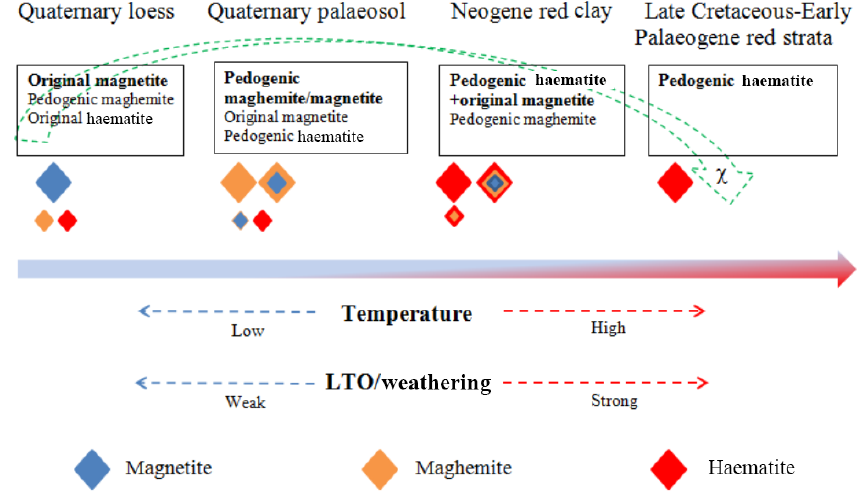
Figure 9. Cartoon illustrating the dominant magnetic minerals and χ changes from Quaternary loess–palaeosol (CLP) → Neogene red clay (CLP) → Upper Cretaceous–lower Palaeogene red strata in the Nanxiong Basin along with the increased temperature and LTO and/or chemical weathering (the size of the symbols indicates the contribution to χ but not the real size of magnetic particles).